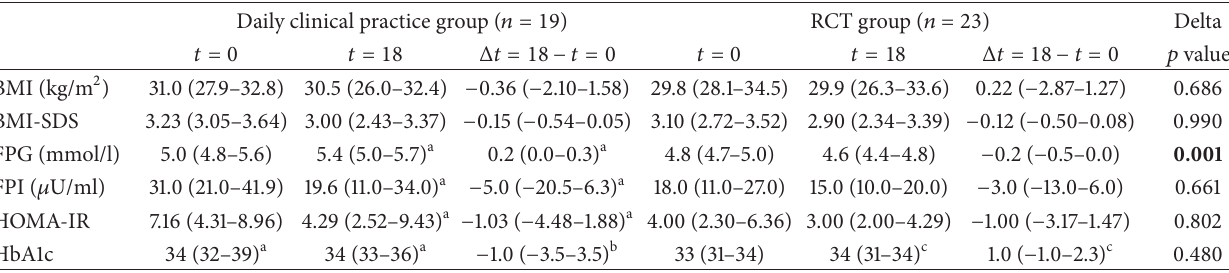
Table 2: Results after 18 months of